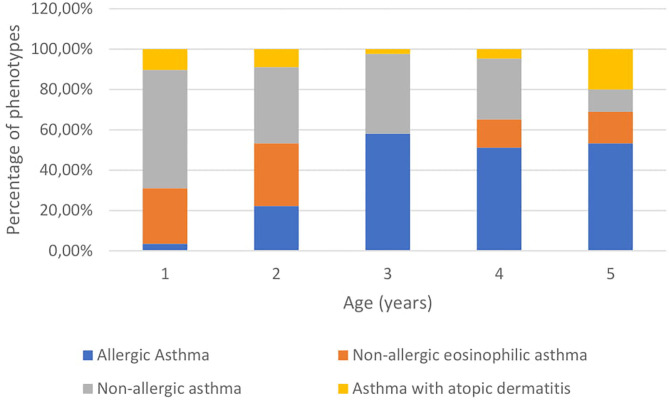
Distribution of phenotypes according to age.